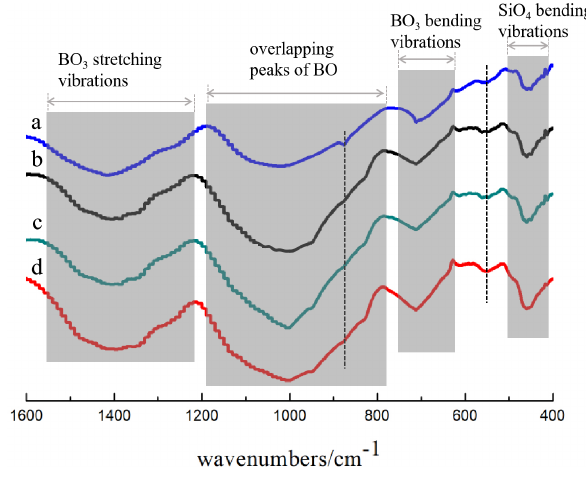
Figure 6: FTIR spectra of slag with different (B 2 O 3 /SiO 2 )